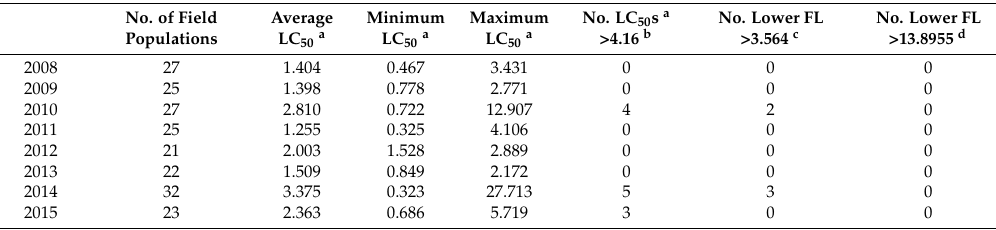
Table 6. Summary of annual responses of tarnished plant bug field population responses to